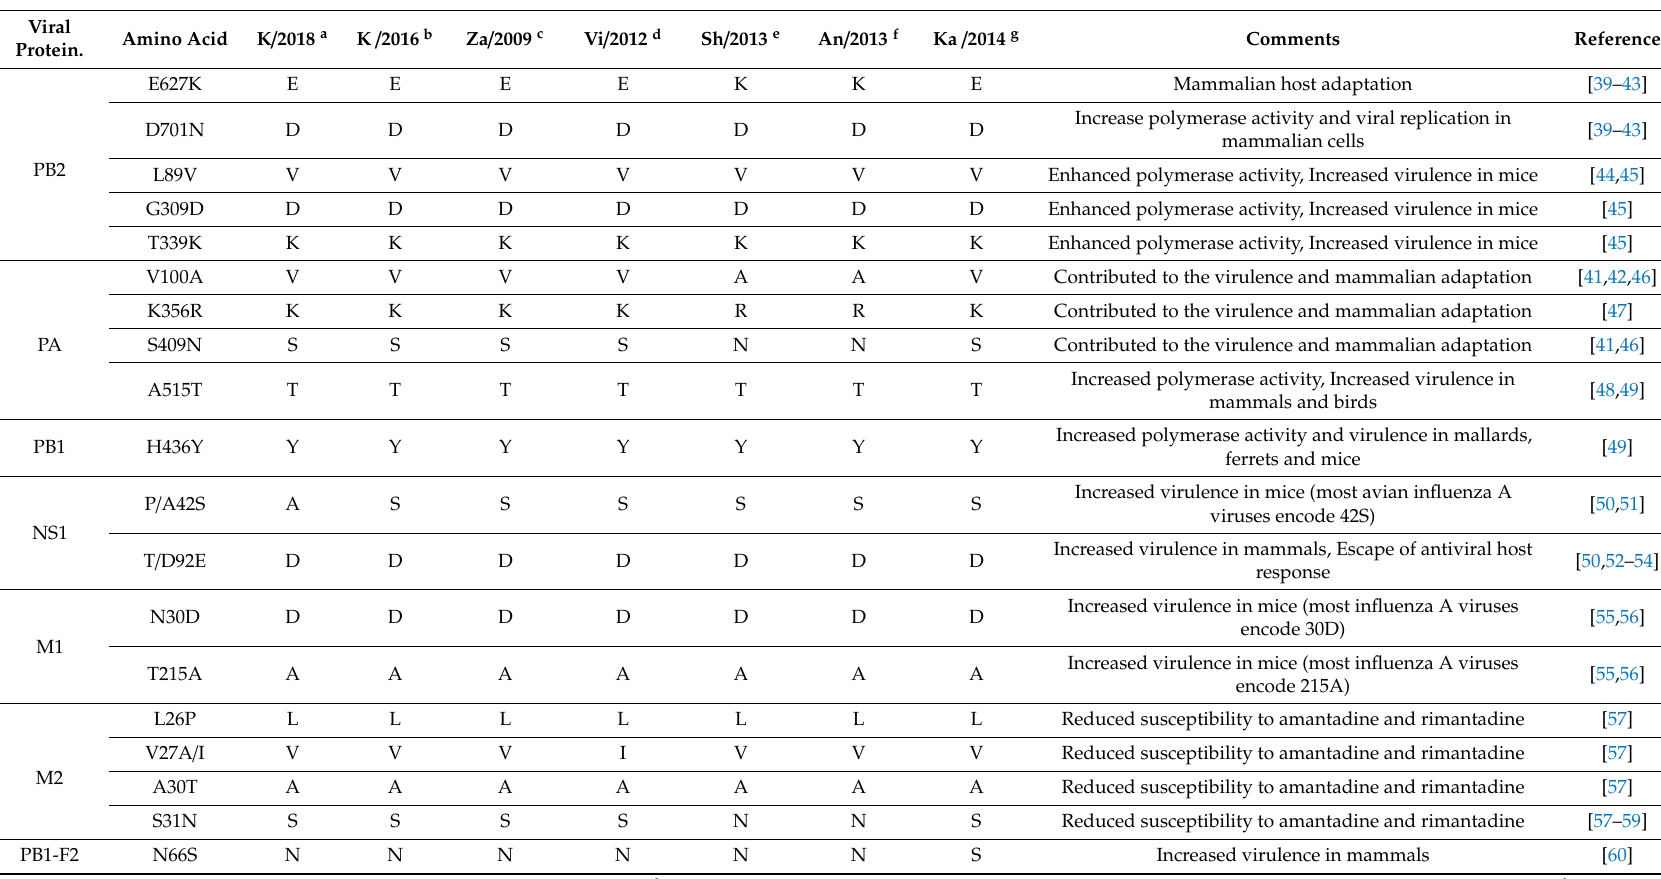
Table 2. Identification of amino acids of the influenza A(H11N9) viruses involved in enhancing antiviral drug resistance and causing pathogenesis in mammals. Viral